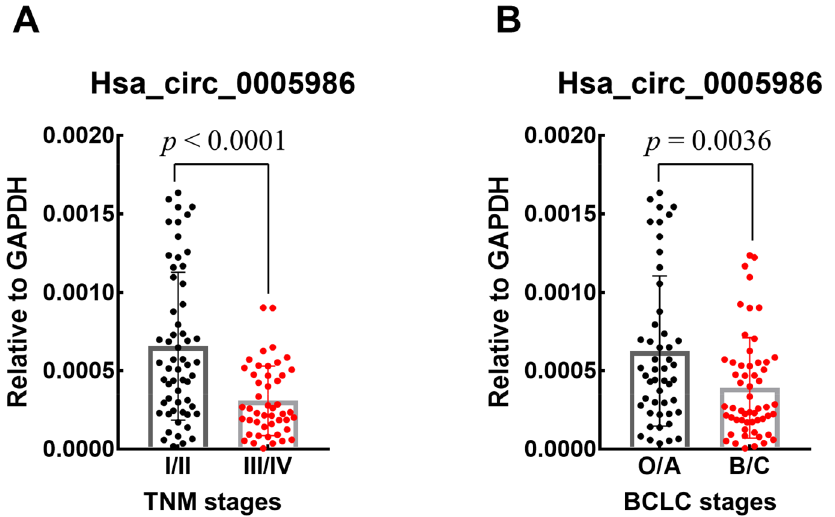
Figure 3. Dot-plot of hsa_circ0005986 expression according to the TNM and BCLC stage. Hsa_circ_0005986 expression was decreased in TNM stage III/IV (A) ( p < 0.0001) and BCLC stage B/C (B) ( p = 0.0036). TNM tumor-node-metastasis; BCLC Barcelona Clinic Liver